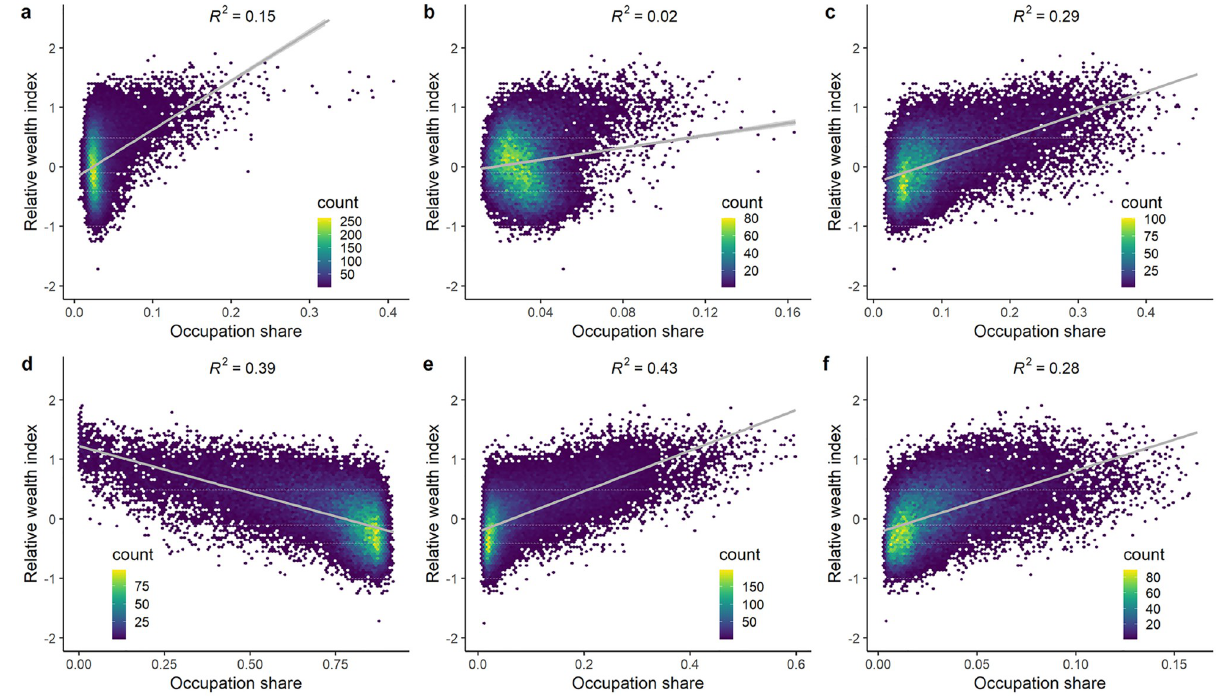
Fig 4. Scatterplot of the relative wealth index from [13] against the predicted occupation shares for (a) Managers and professionals, (b) Technicians and associate professionals, (c) Clerks and service workers, (d) Agricultural workers (e) Craft workers and operators and (f) Elementary occupations.